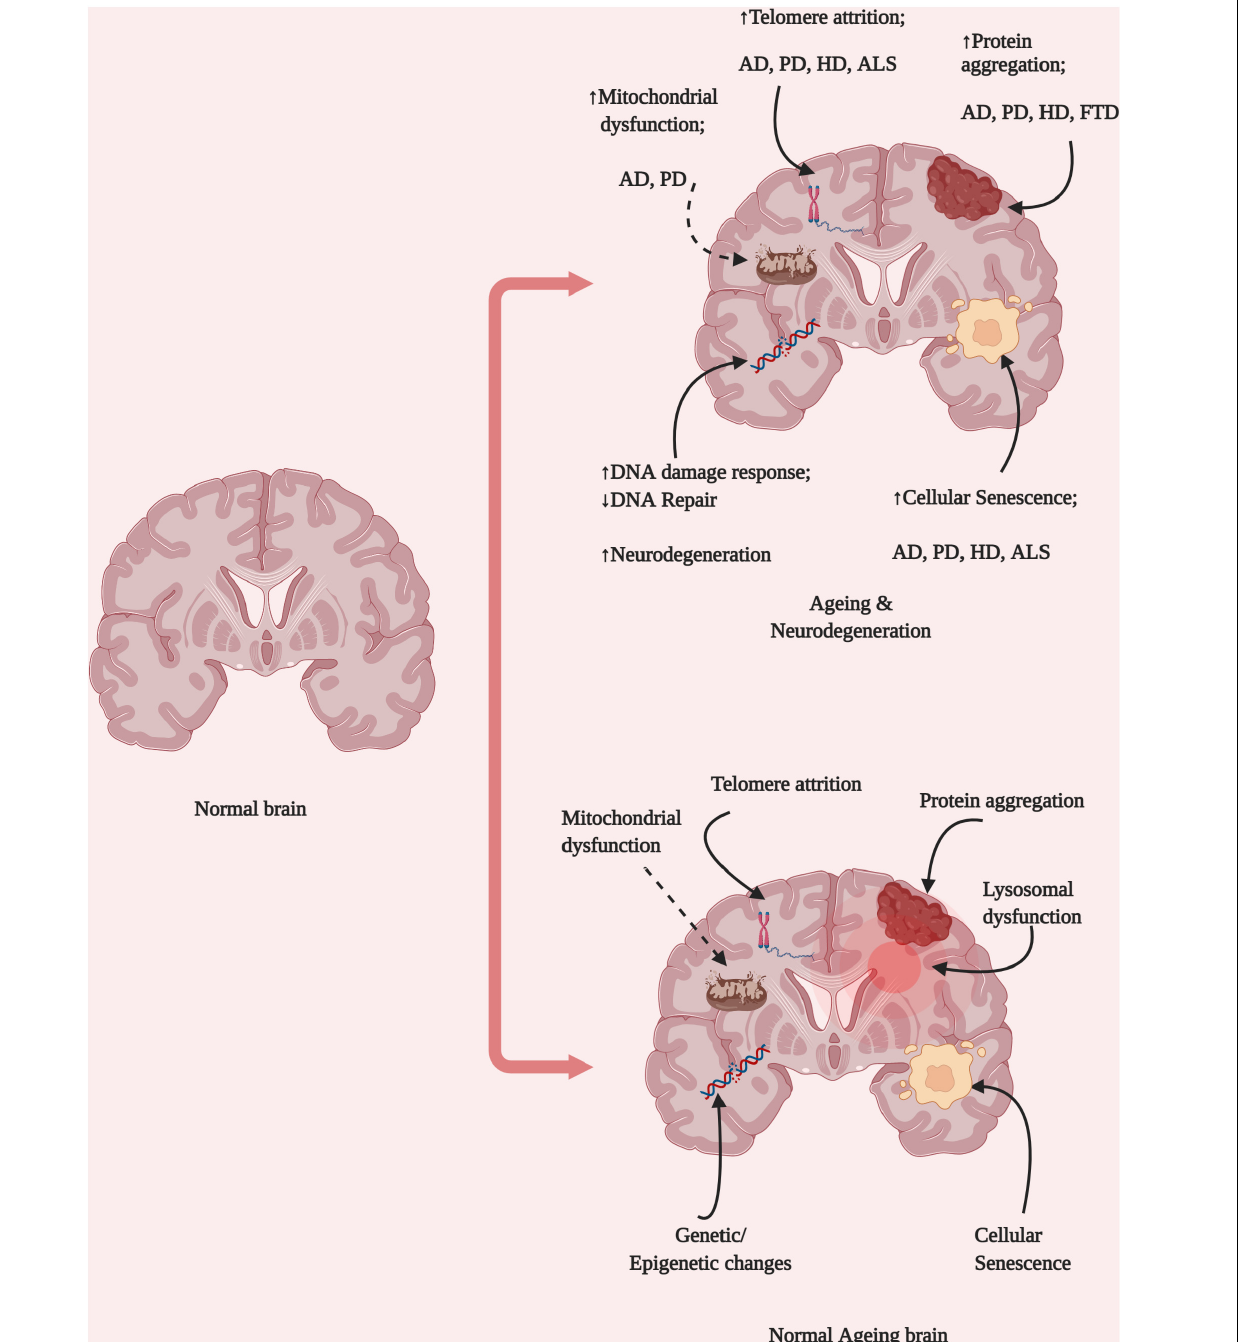
epigenetic alterations, telomeric attrition, and the loss of proteostasis. Antagonistic hallmarks refer to compensatory responses to primary damage associated with ageing, including